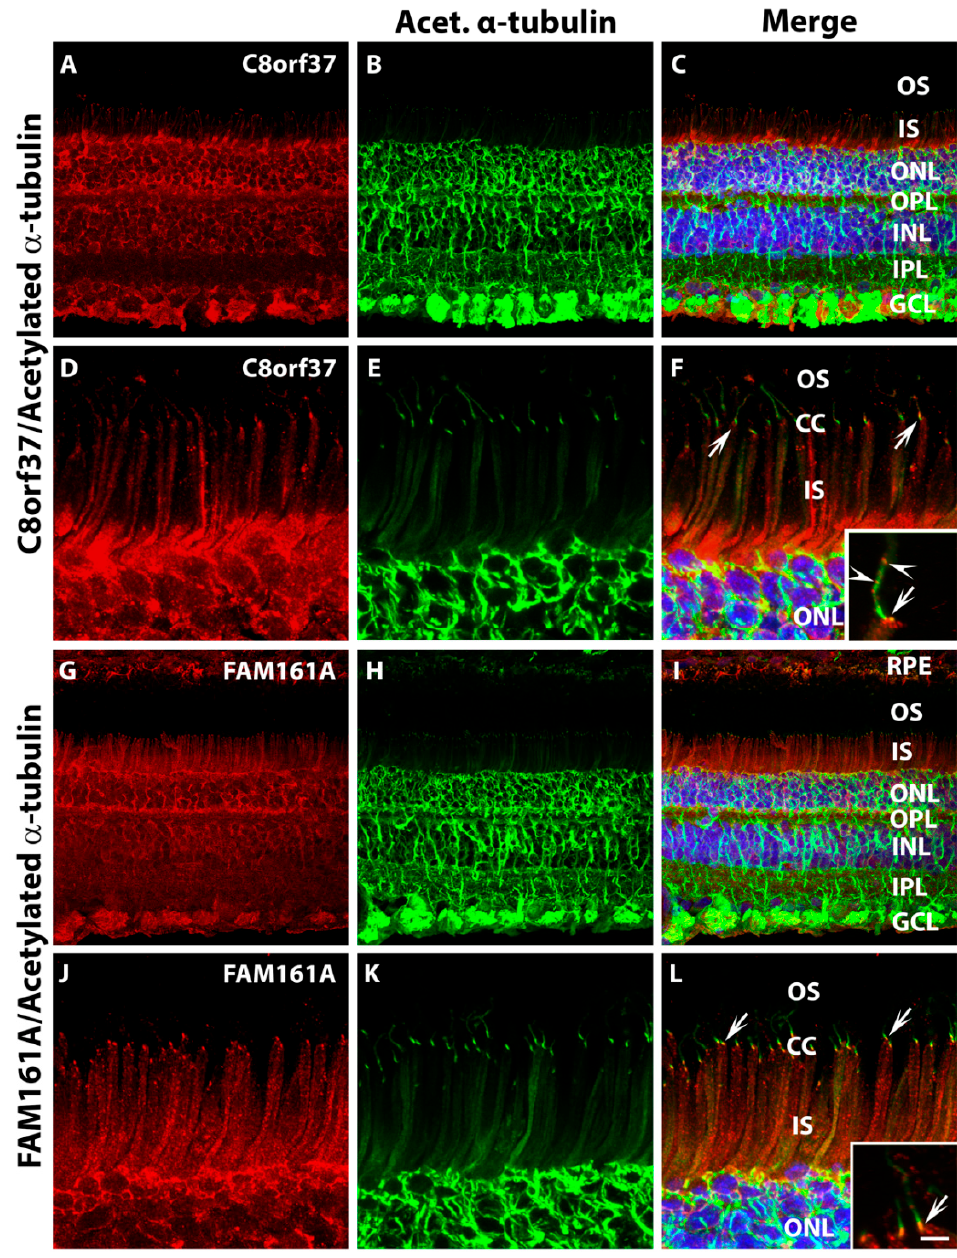
Figure 1. C8orf37 and FAM161A were widely expressed in the marmoset retina. Marmoset retinal sections were double-immunostained with anti-C8orf37 (red) and anti-acetylated α -tubulin (green) ( A – F ) or anti-FAM161A and acetylated α -tubulin (green) ( G – L ). The sections were counterstained with DAPI (blue). Images ( A – F ) show C8orf37 and acetylated α -tubulin double staining. C8orf37 immunoreactivity was observed in the inner segment layer, outer nuclear layer, inner nuclear layer, and ganglion cell layer. C8orf37 immunoreactivity puncta was also observed at the base of acetylated α -tubulin-labeled cilia (arrows in F ), as well as along the cilia (arrowheads). Images ( G – L ) show FAM161A and acetylated α -tubulin double staining. FAM161A immunoreactivity was widely distributed in the retina. Its puncta were also enriched at the base of cilia (arrows in L ) and along the cilia. Abbreviations: GCL, ganglion cell layer; INL, inner nuclear layer; IPL, inner plexiform layer; IS, inner segment; ONL, outer nuclear layer; OPL, outer plexiform layer; OS, outer segment. Scale bar: 20 μ m for ( A – C ) and ( G – I ); 6 μ m for ( D – F ) and ( J – L ); 3 μ m for insets in ( F ) and ( L ). To evaluate whether C8orf37 and FAM161A were co-localized, we performed prox- imity ligation assays by conjugating anti-C8orf37 and anti-FAM161A antibodies with Du- olink™ In Situ Probemaker PLUS probes and Duolink™ In Situ Probemaker MINUS probes (Sigma Aldrich, Burlington, MA, USA), respectively. When both C8orf37-